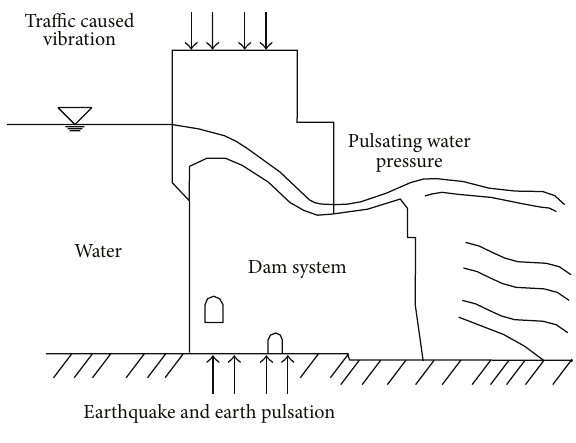
Figure 1: Ambient excitation sources of